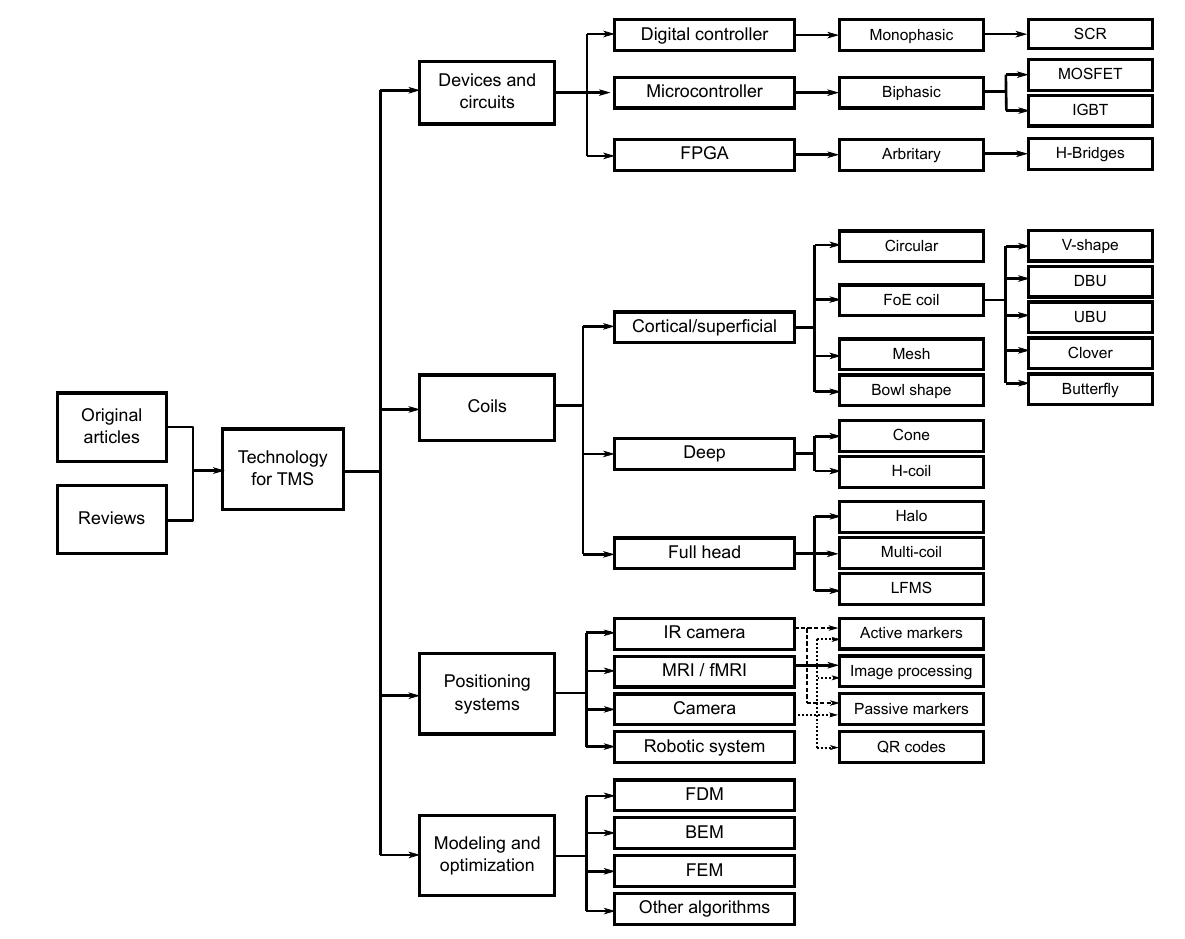
Figure 3. Taxonomy of TMS technology of this Systematic Literature